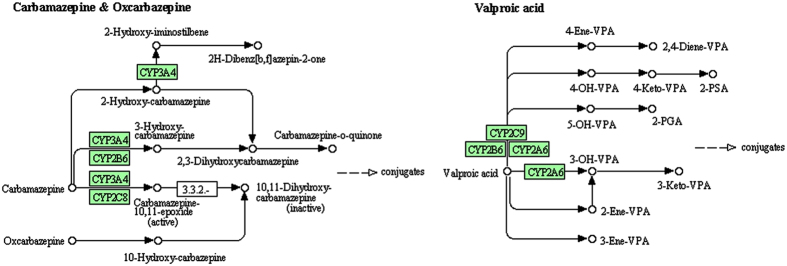
Informatics analysis showing an example of the differentially methylated genes as a part of the hsa00980 pathway.This pathway participates in the metabolism of multiple drugs (see Supplementary Fig. 4). Shown are the parts related to the metabolism of several commonly used antiepileptics, i.e., carbamazepine, oxcarbazepine and valproic acid. Images are obtained from KEGG (http://www.kegg.jp/kegg/kegg1.html) with permission (Ref. #: 16835).